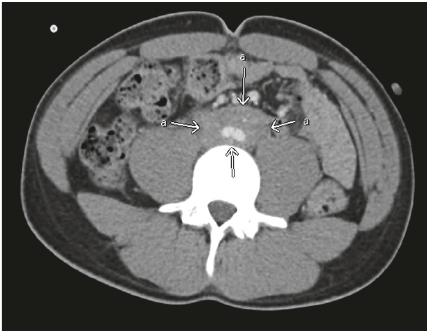
Figure 2: Abdomen and pelvis computed tomogram with intra- venous contrast revealed mild bilateral hydroureteronephrosis with point of obstruction at the level of distal abdominal aorta and inferior vena cava. There was an ill-defined, infiltrative soft tissue mass encasing both aorta and IVC (approximately7.2 cm). The mass appeared to infiltrate along the bilateral proximal common iliac